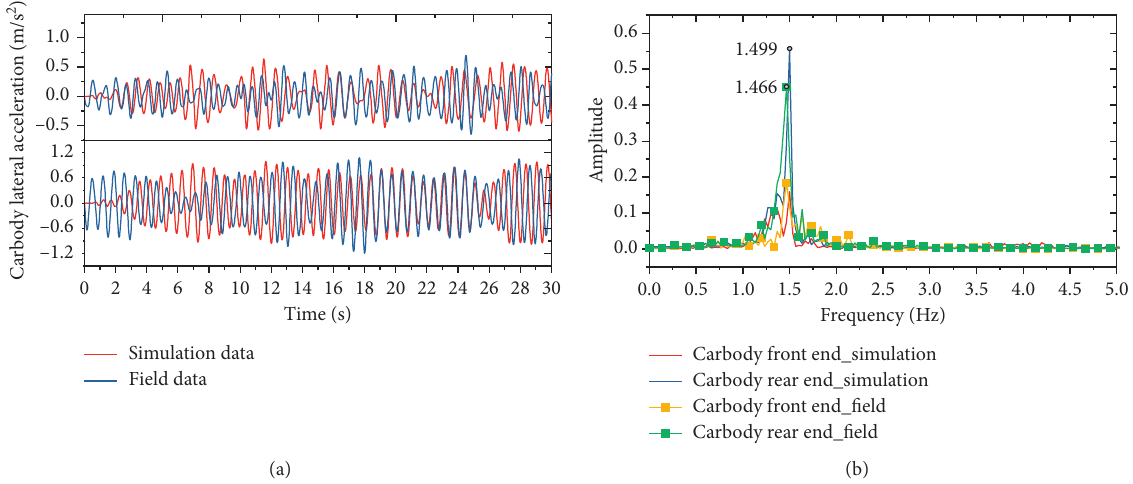
Figure 7: Comparison between simulation and field data. (a) Time domain (band pass filtered by 0.5–3Hz) and (b) frequency domain.